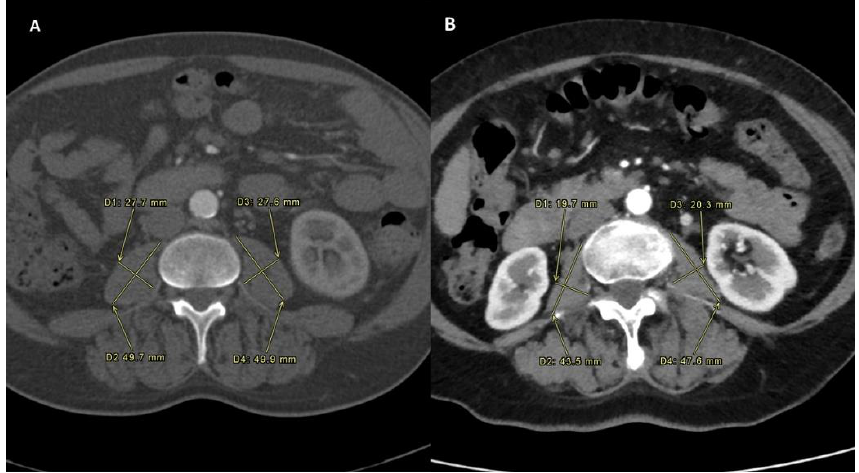
Figure 1. Sarcopenia status measured before the intra-arterial radioembolization in both the Sarcopenia group ( A ) and No-Sarcopenia group ( B ). Sarcopenia status was defined as a decrease in the delta PMI calculated comparing the PMI values at the time of TARE and one month after